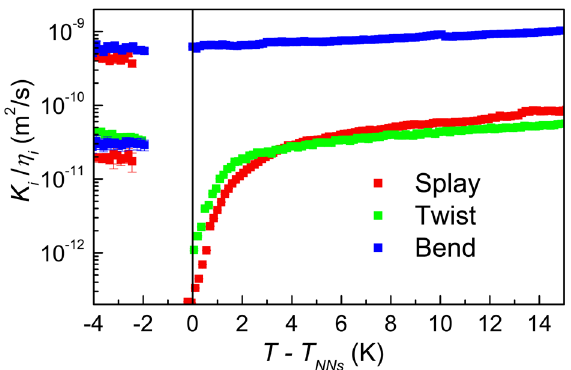
FIG. 6. Temperature dependence of ratios K proportional to the relaxation rates of orientational fluctuations. The cooling rate is 0 . 03 K = min. In the temperature region where the orientation is not homogeneous, we were not able to reliably = η determine K . i i